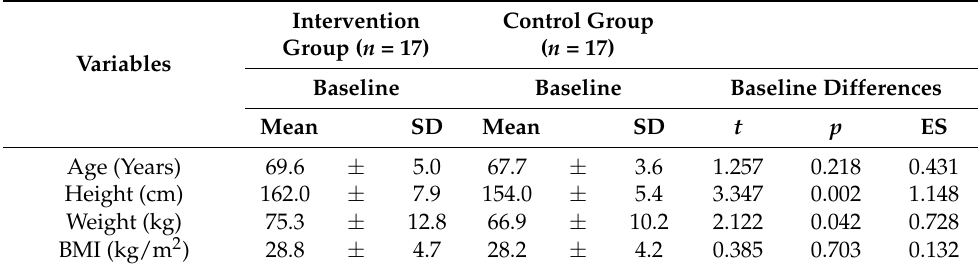
Table 1. Baseline characteristics of study participants.